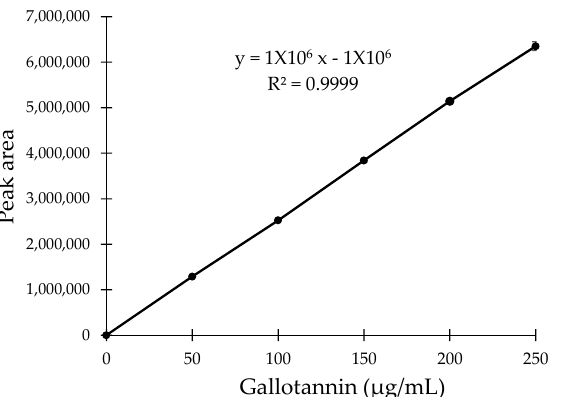
Figure 4. Standard calibration curve to determine the concentration of gallotannin in the fractionated QI extract (F1 to F6). Table 2. Total concentration and recovery percentage of the gallotannin compound in the fractionated QI extract (F1 to F6). Initial Material (100 µg/mL)